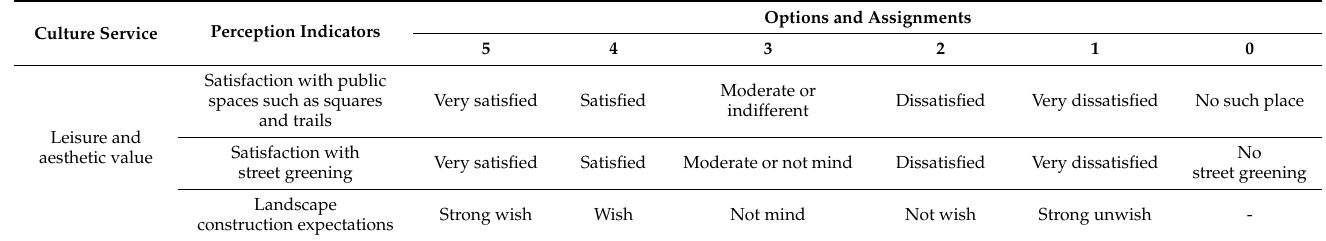
Table A4. Culture service perception indicators, options, and values.